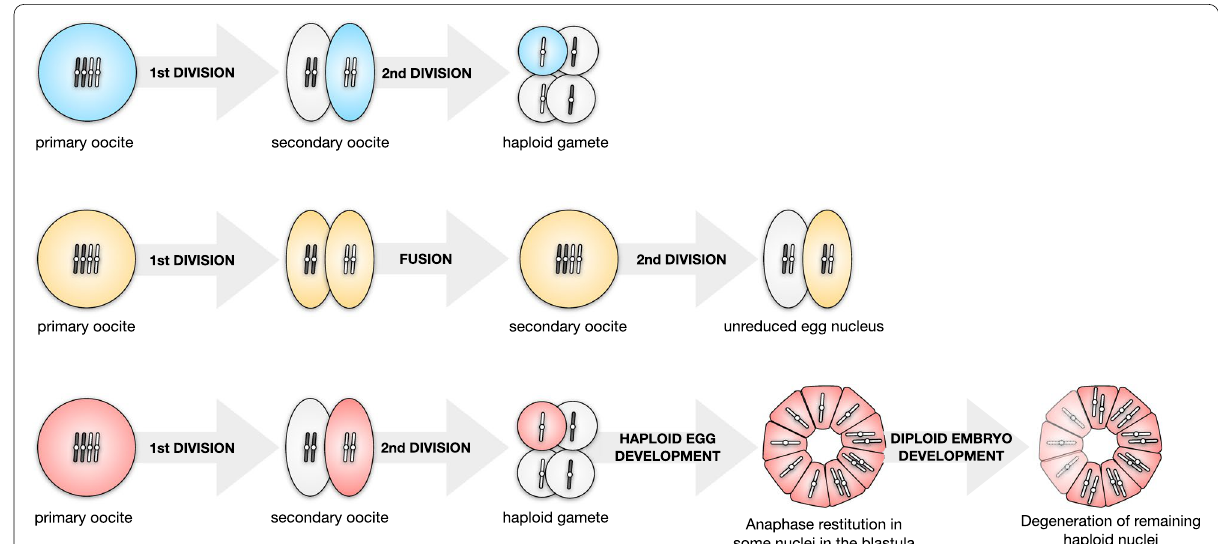
Fig. 1 Overview of the oogenesis processes in a the bisexual Bacillus grandii maretimi (blue) and in the two parthenogens, b Bacillus atticus (yellow) and c Bacillus rossius rossius